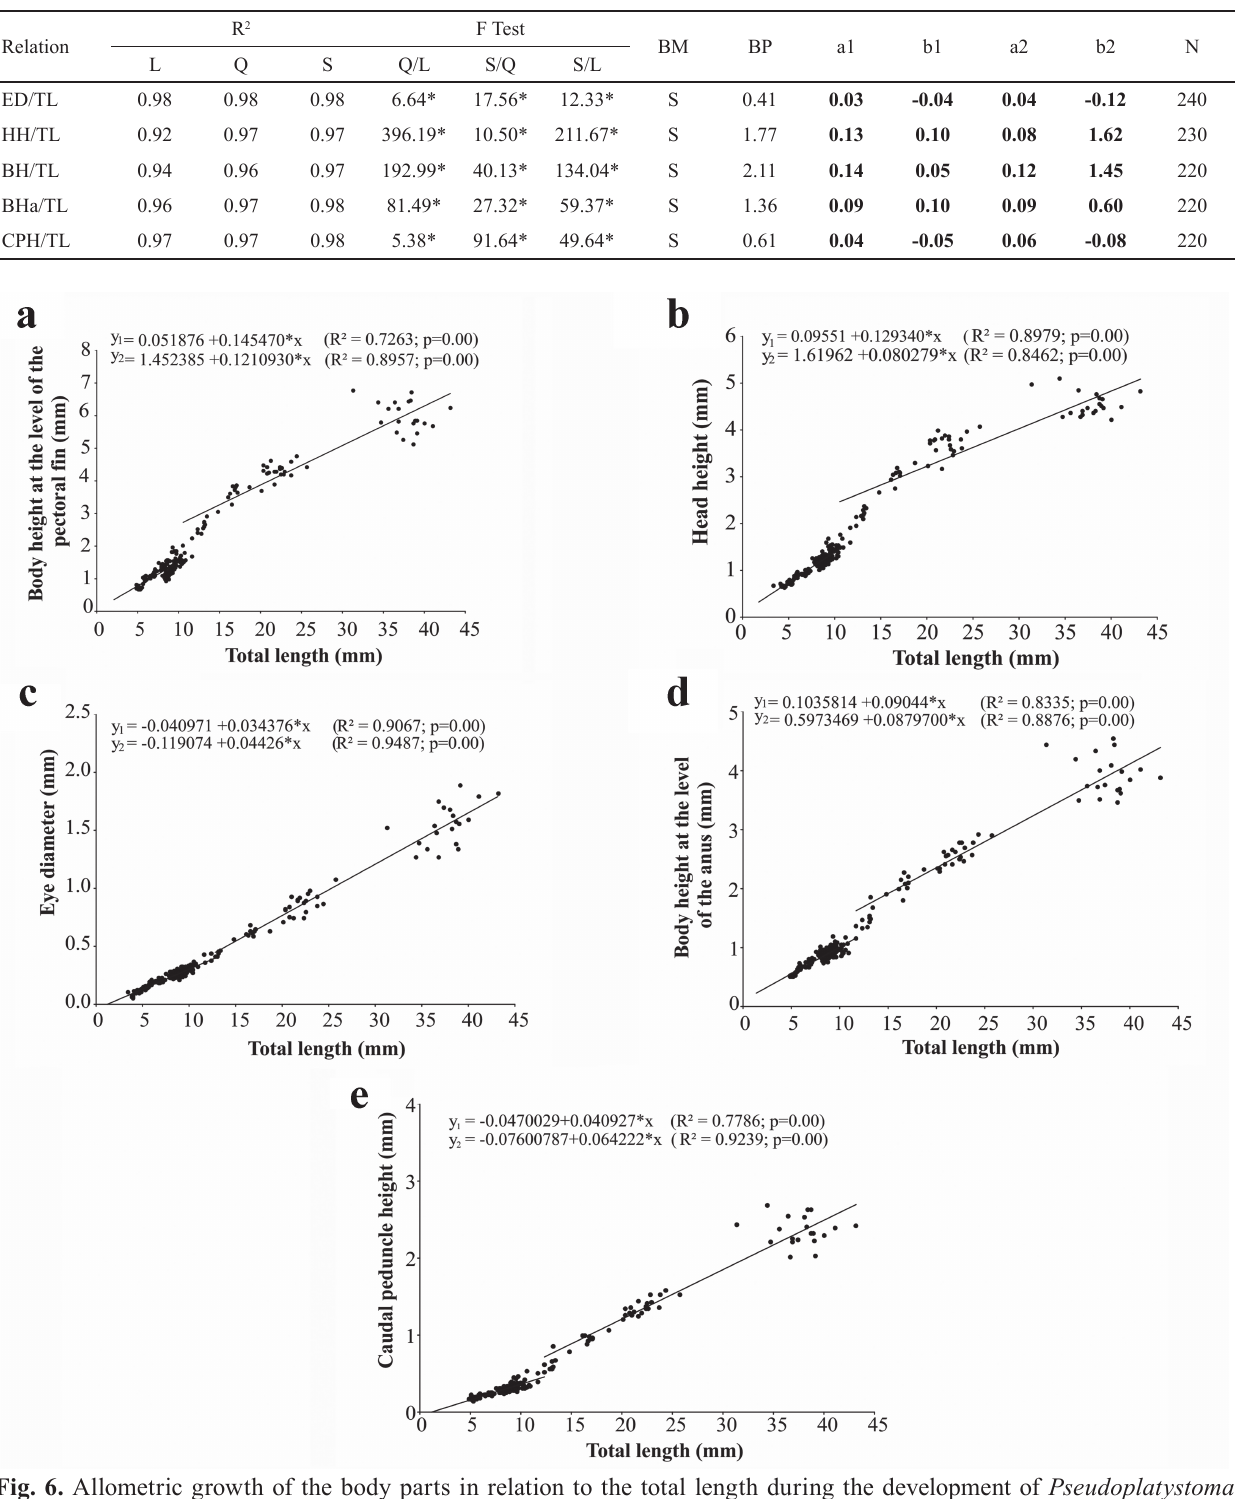
Table 2. Values of the linear (L), quadratic (Q) and piecewise linear (S) regression analysis of the morphometric variables obtained relative to the total length of the larvae and juveniles of Pseudoplatystoma reticulatum . R 2 =coefficient of determination, BM =best model, BP =breakpoint (mm), a and b =regression parameters (a, slope coefficient; b, linear coefficient), N =number of individuals analyzed, ED =eye diameter, HH =head height, BH =body height, BHa =body height at the level of the anus, CPH =caudal peduncle height. (*) =p<0.05, bold =values of the significant regressions.